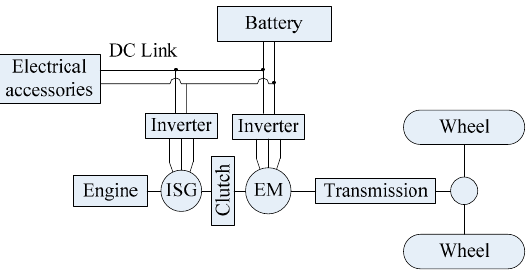
Figure 1. Configuration of the public transit hybrid electric bus (PTHEB).